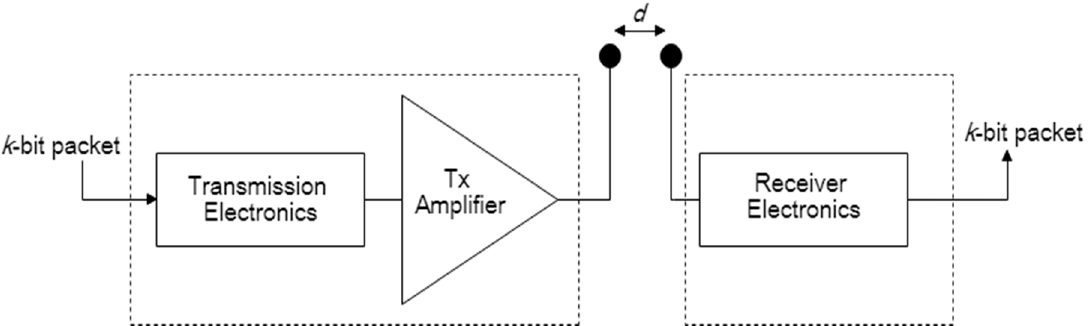
Figure 2. The Radio Energy Model. Figure 2. The radio energy